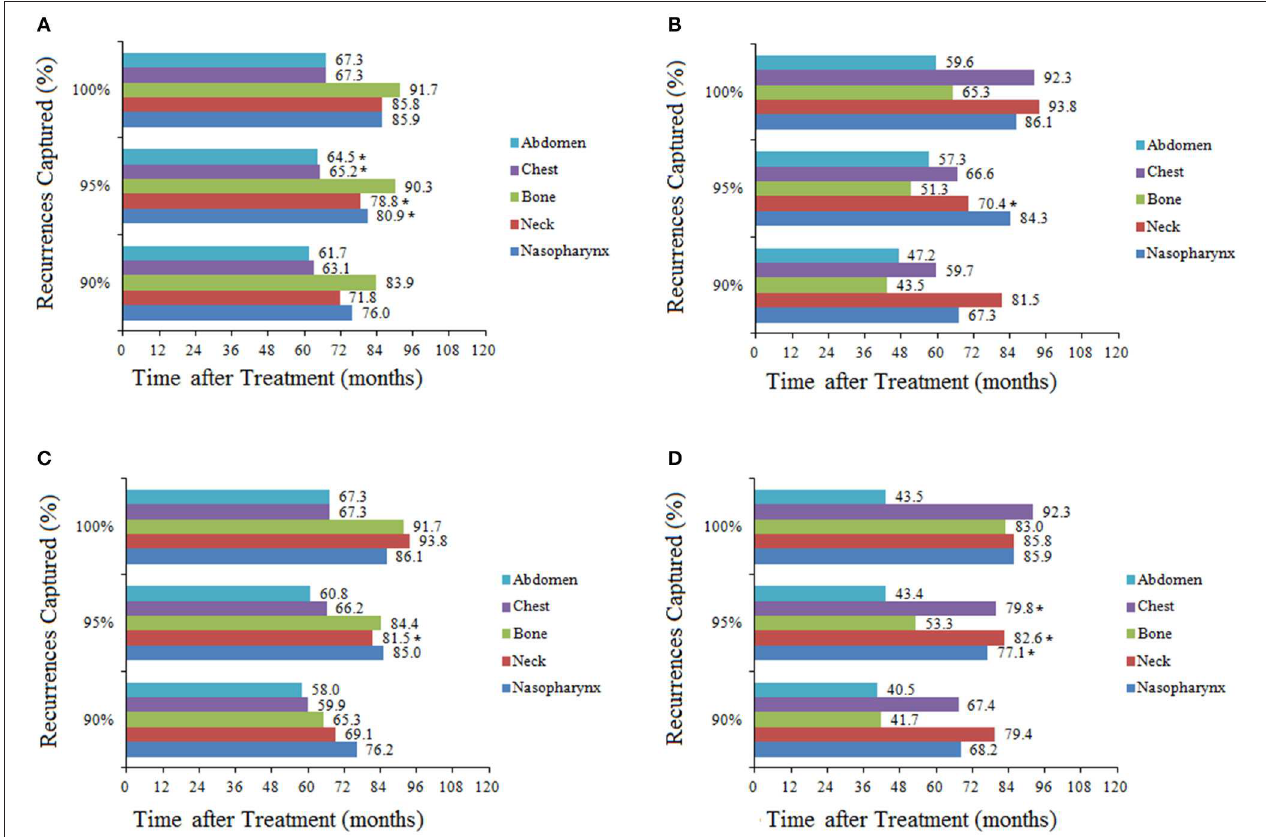
FIGURE 2 | Total duration of surveillance required to capture 90, 95, and 100% of recurrences in patients stratified by stage and recurrence location: (A) T1/2; (B) T3/4; (C) N0/1; (D) N2/3. *Estimated duration of surveillance due to there being few recurrences in these groups.